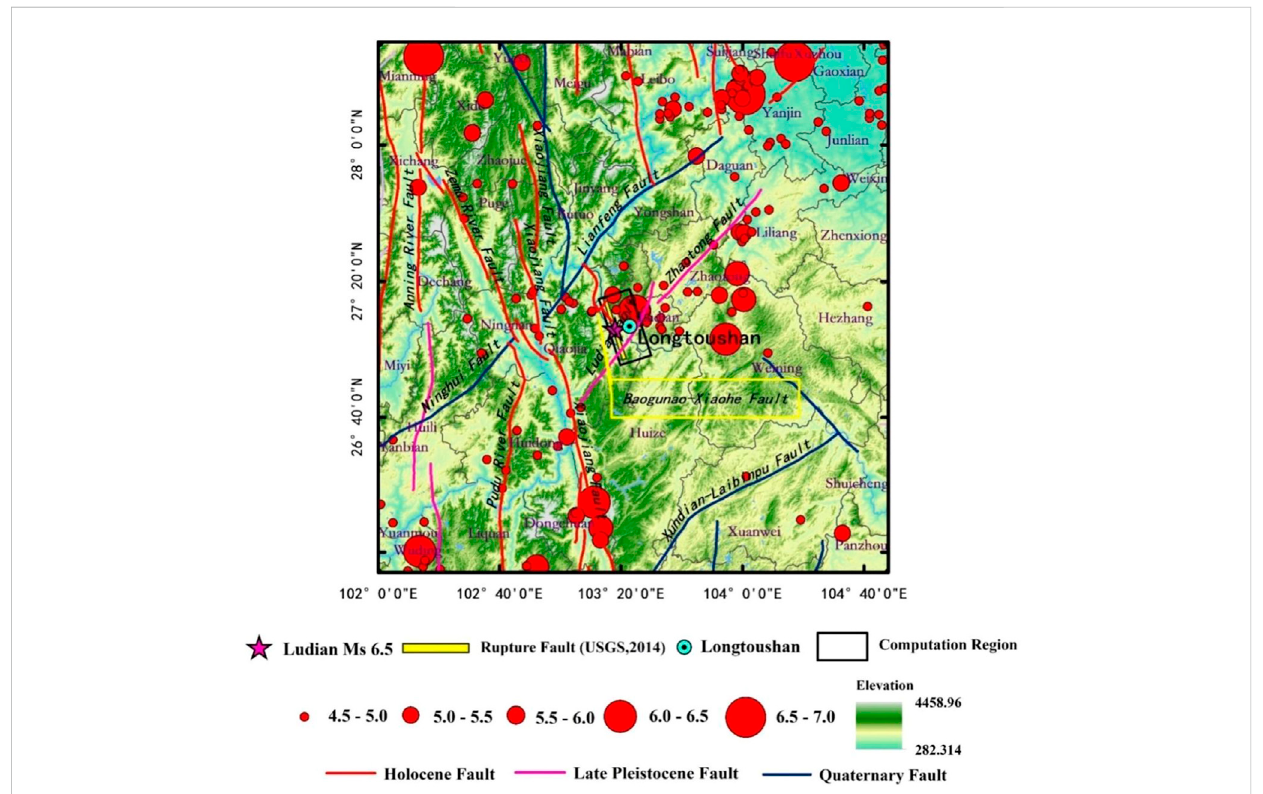
FIGURE 1 Seismogenic structure and historical seismicity around the M6.5 Ludian earthquake. The pink star and the yellow rectangular with black border outlinetheepicenterandprojectionoftherupturefaultofthisearthquakeprovidedbytheUSGS,respectively.Theareawithintheblackrectangularisthe study area. Red circles of different sizes represent historical earthquakes of different magnitudes. The red, pink, and blue lines represent Holocene, Late Pleistocene, and Quaternary faults, respectively.